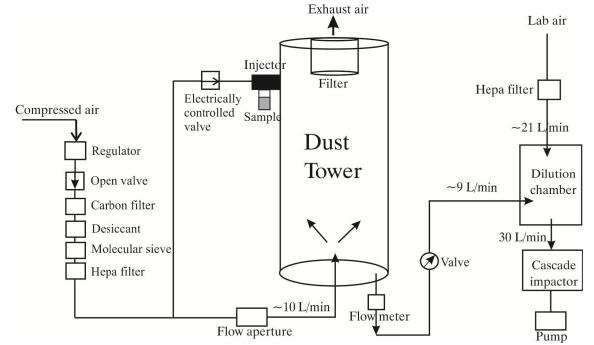
Fig. 1 Sketch diagram of the particle re-suspension and collection system Fig. 1. Sketch diagram of the particle re-suspension and collection